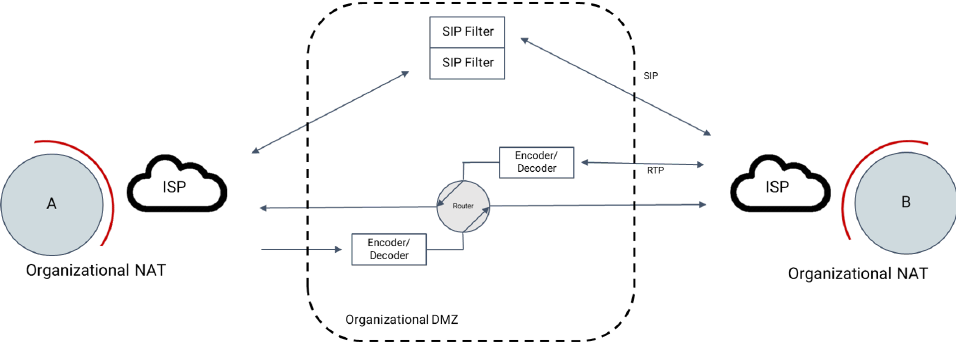
Figure 7. Graphical illustration: Holistic Approach for RTP connection between organizations connected by a demilitarized zone